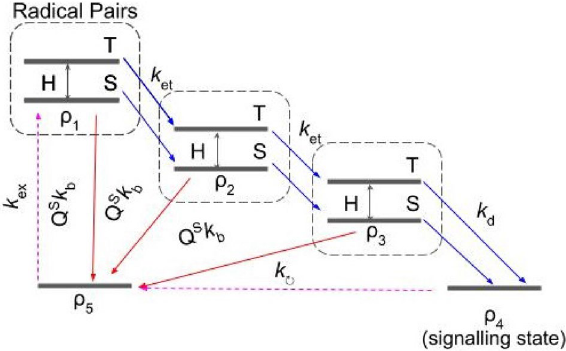
Figure 4. Effective model of the cryptochrome radical pair mechanism. The first radical pair is created in the state ρ 1 by an excitation of the precursor molecule ρ 5 . Electron hopping gives rise to other pairs, ρ 2 and ρ 3 . Their spin dynamics, coherent evolution between the singlet (S) and triplet (T) states, depends on the external magnetic field and they can recombine to the precursor only if they are in the singlet state. This selective recombination is represented by the singlet projectors Q S in front of the back-transfer rates, k b , and modifies the yield of the signalling state ρ 4 , perceived by the animal. Variants of the model with solid transitions have been studied previously, see e.g. 43,48,49 . We also consider the model with additional dashed arrows, which close